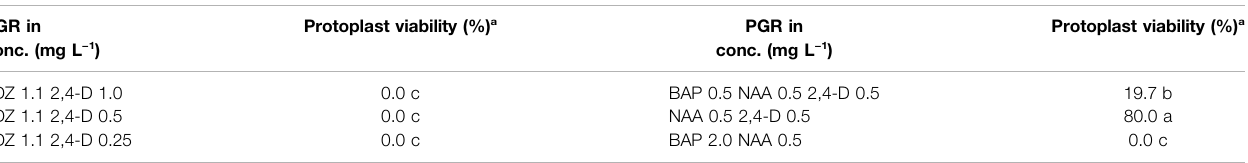
TABLE 2 | Effect of PGRs in MI medium on protoplast viability of fi eld cress. PGR in conc. (mg L − 1 )